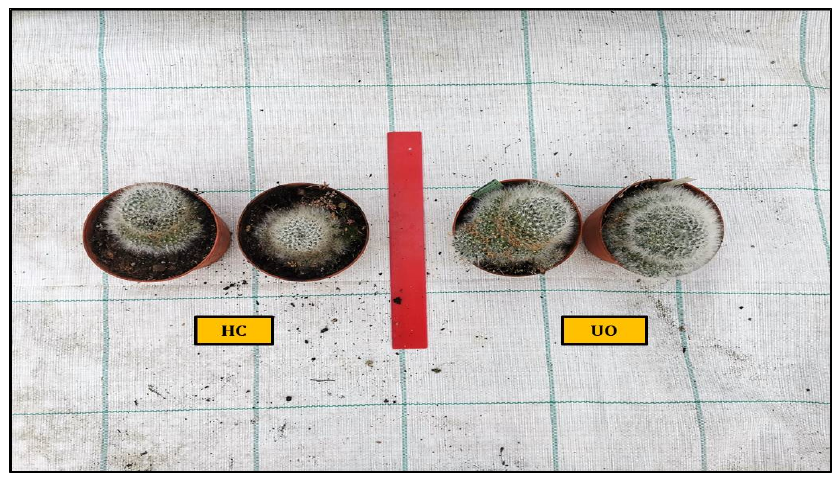
Figure 4. Comparison of the vegetative growth of Ulva ohnoi (UO) and Hypnea cornuta (HC) in Mammillaria glassii.